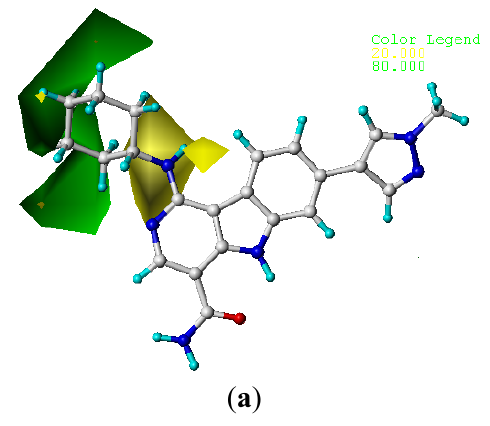
Figure 2. CoMFA StDev*Coeff contour maps. ( a ) Favorable (green) and unfavorable (yellow) steric fields; ( b ) Electropositive (blue) and electronegative (red) fields. Compound 22 was overlaid in each